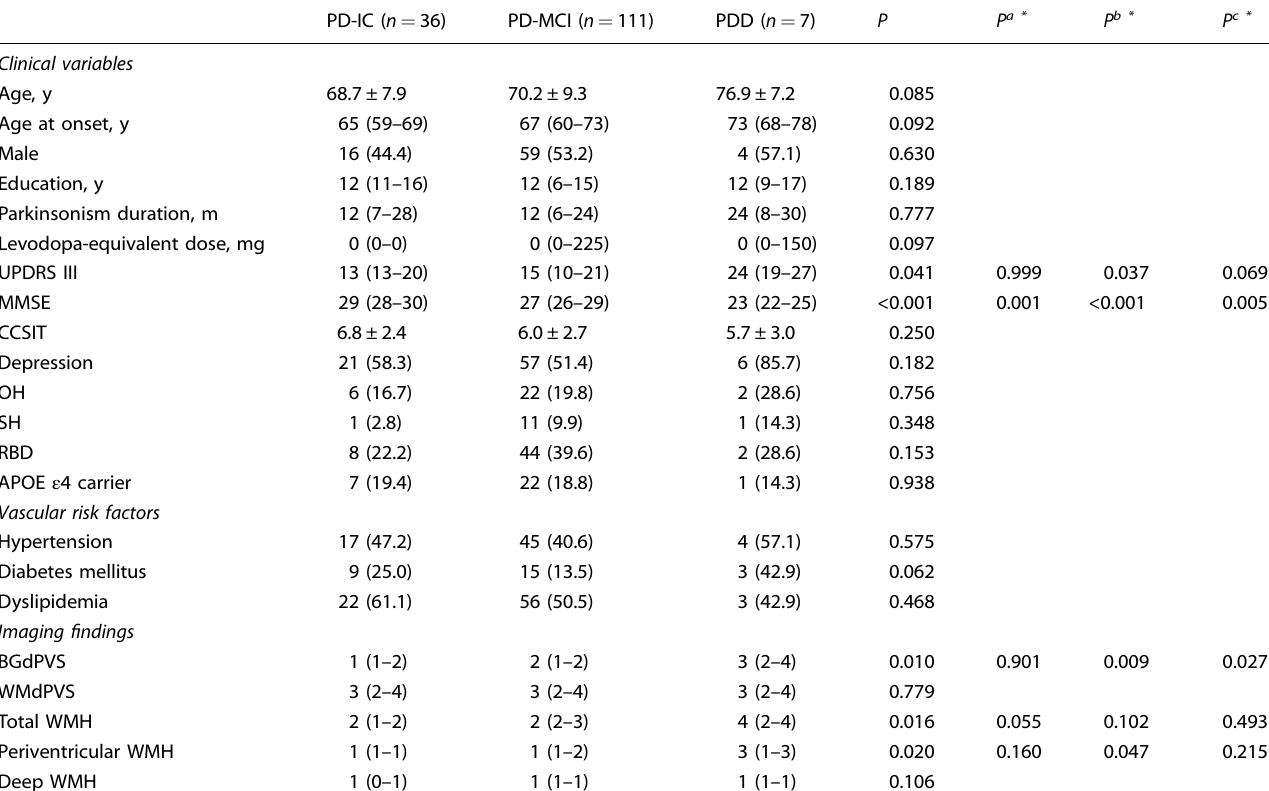
Table 1. Clinical and imaging characteristics of